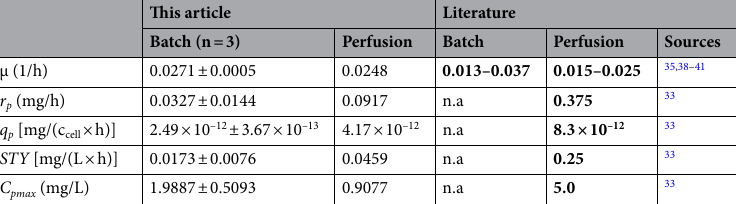
Table 1. Mean growth rate µ, production rate rp, cell-specific production rate qp, space–time yield STY and maximum product concentration Cpmax for the batch processes (n = 3) and the 55-h steady-state phase of the perfusion process with a macrosparger. Literature data for stable Sf-9 cell lines converted to the units used herein are shown in bold.